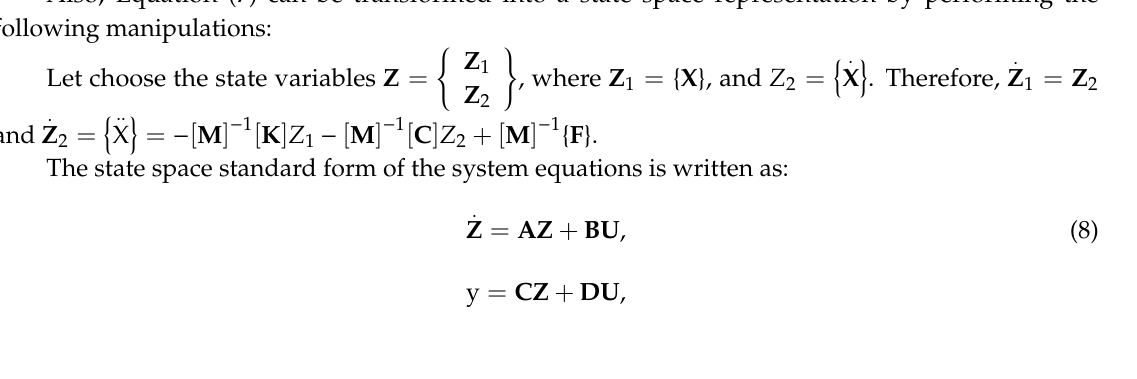
Figure 3. ( a ) Front view of the wheelset at curve with a cant of ϕ 0 . ( b ) Plan view of the wheelset. Dashed lines represent the wheelset in centered position, and the continuous lines represent the yawed wheelset by an angle ψ .